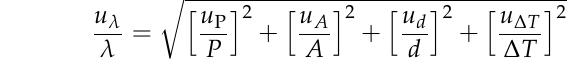
Figure 6. Thermal conductivity of aerogel felt at 50 °C~280 °C under atmospheric pressure.